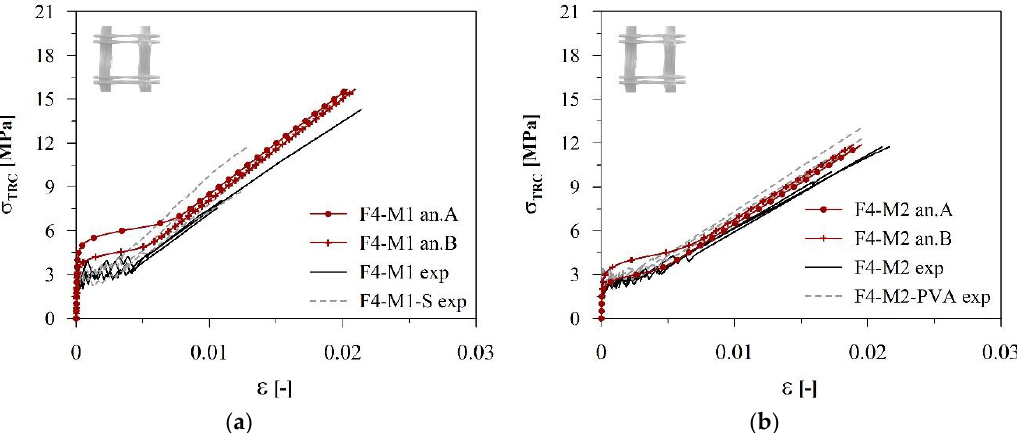
Figure 18. Comparison between the predicted analytical curves and the experimental responses in terms of nominal stress vs. strain for M1-based ( a ) and M2-based ( b ) composites reinforced with Fabric F4.